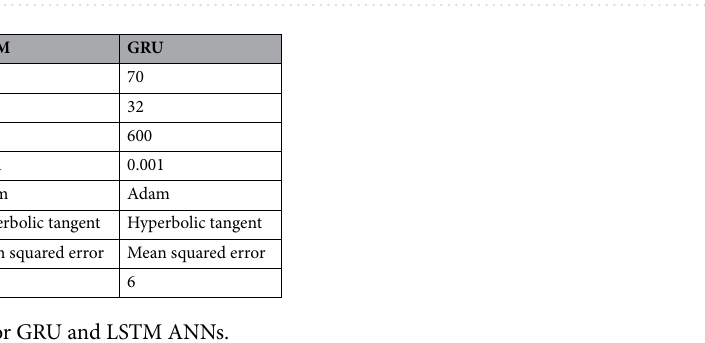
Figure 3. 14-day cumulative incidence (CI) in Spain. The evaluation dates are highlighted to let the reader know the trend of 14-day CI at that period.